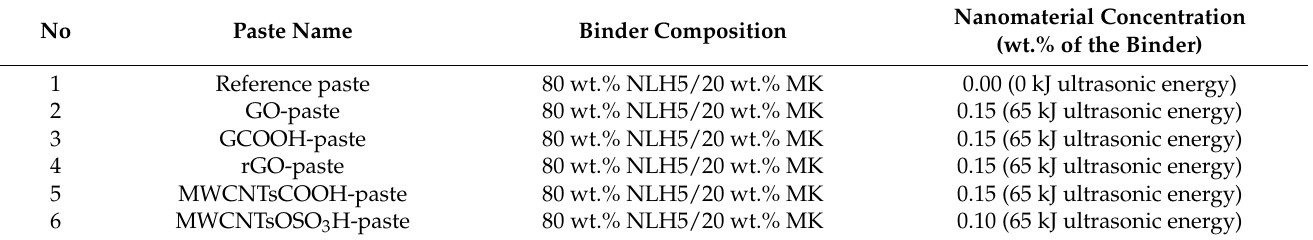
Table 2. Composition of the produced pastes.